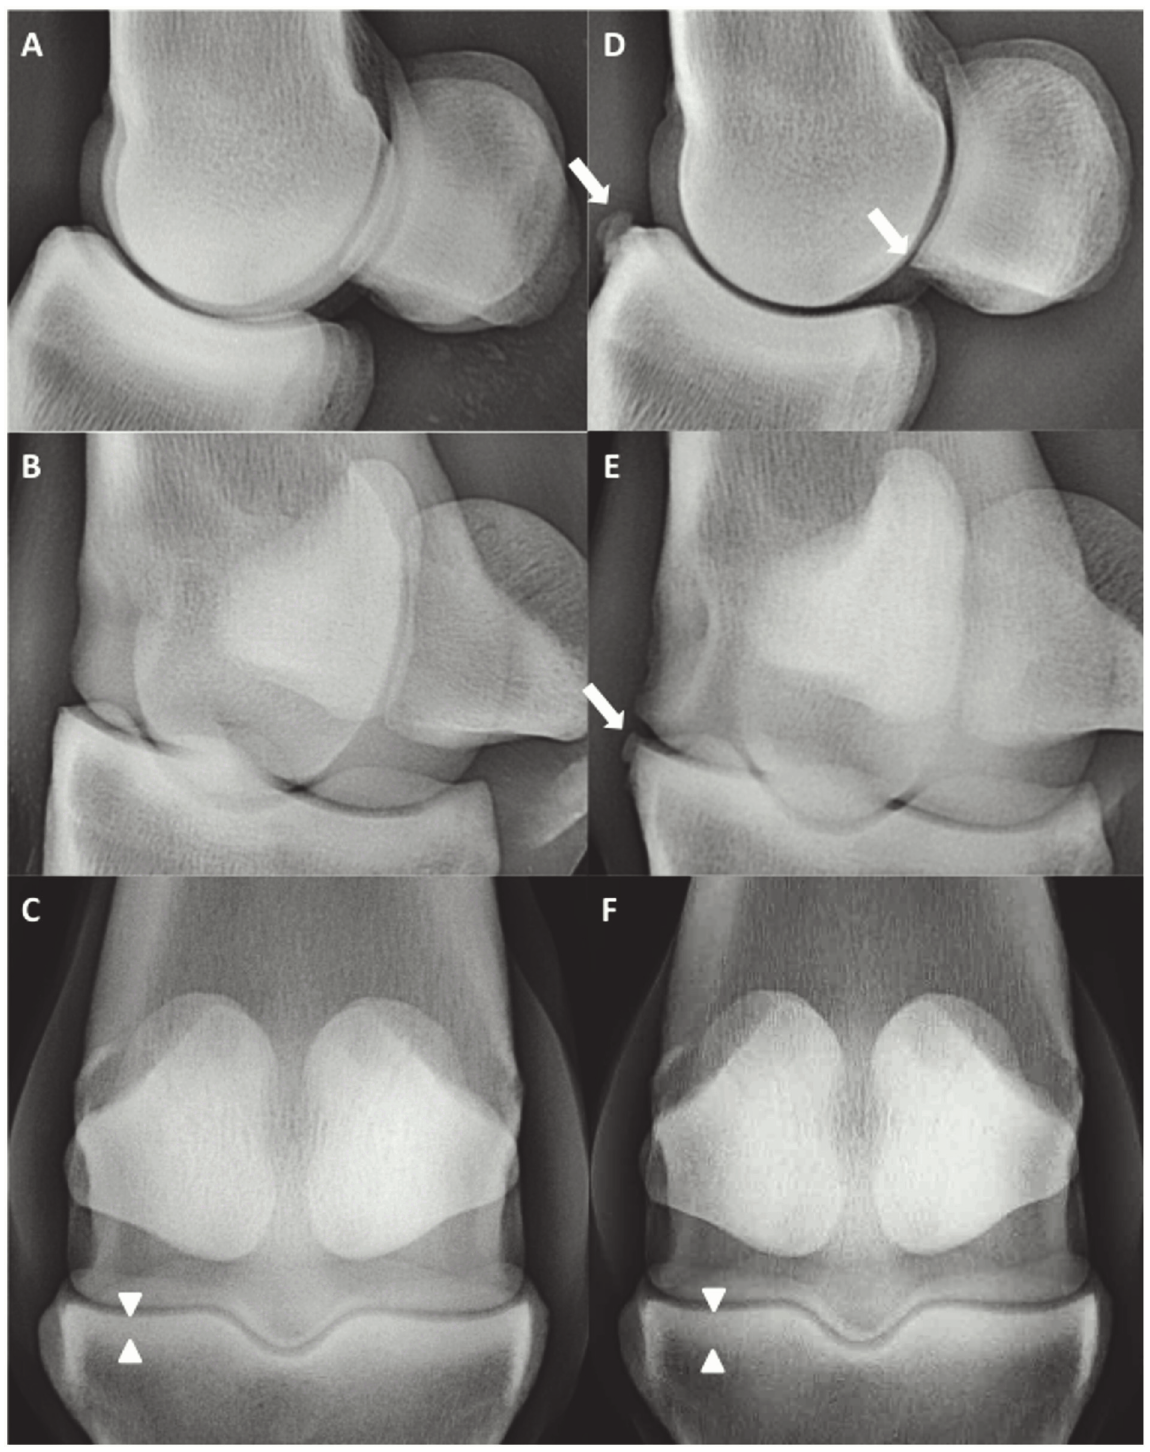
Figure 3. Radiographic views of the MP joint of an individual at week 0 (A, B, C) and week 10 (D, E, F). A and D show the latero-medial view, B and E show the 45-degree oblique view, and C and F show the dorso-palmar view. Grade 1 to 2 osteophytes (white arrows) and grade 1 sclerosis (white triangles) are